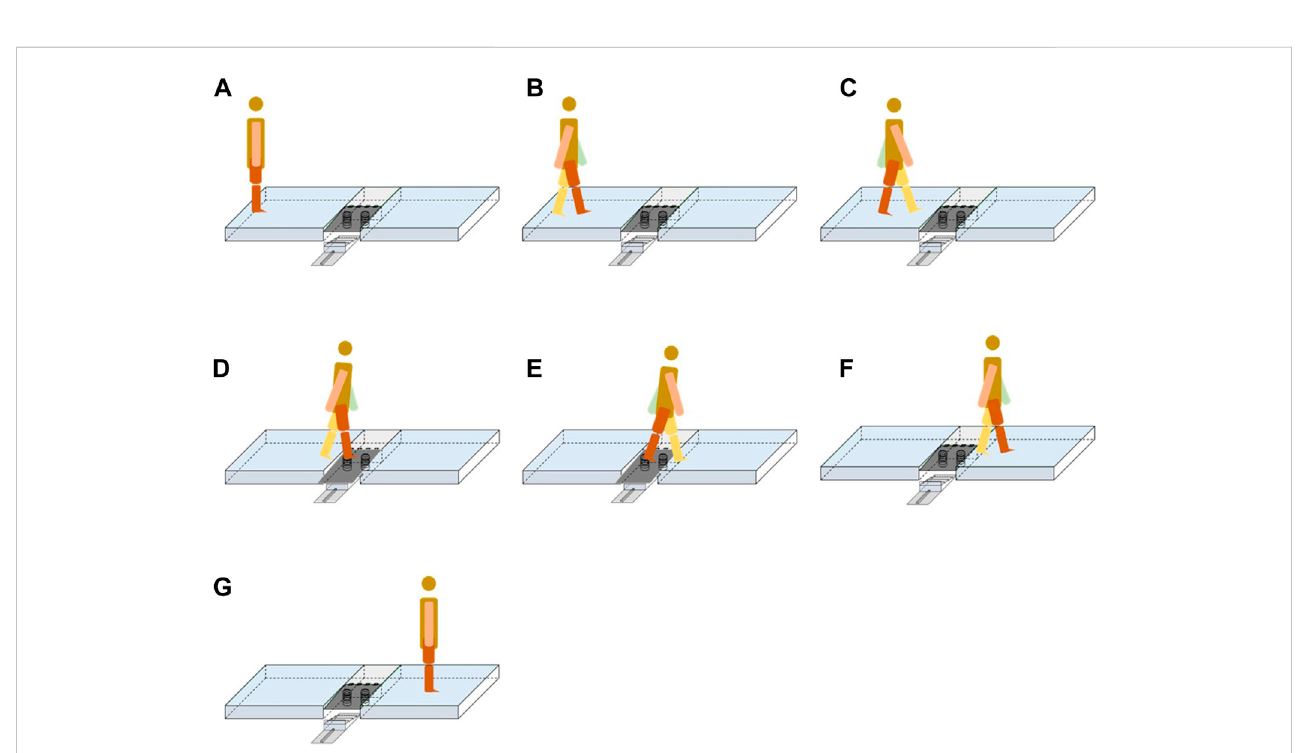
The test phase of the AIDAW. (A) starting position; (B) Step 1; (C) Step 2; (D) Step 3; (E) Step 4; (F) Step 5; (G) Step